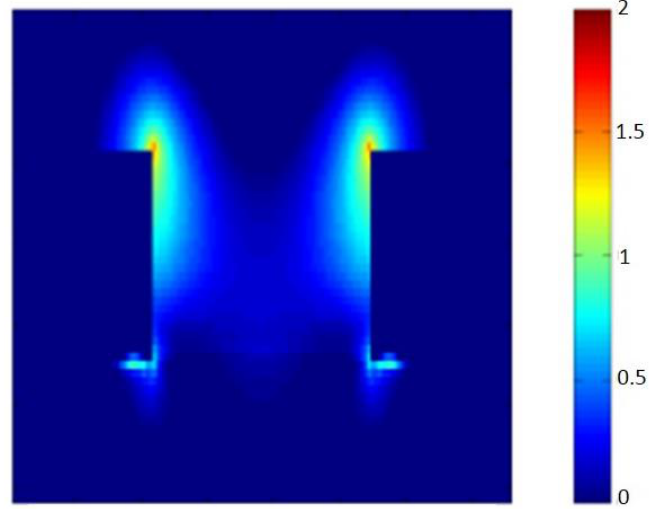
Figure 1. Electric field in the gap between two gold cylindrical nanoparticles for an incident plane wave of wavelength 650 nm. The nanoparticles are in a two-dimensional hexagonal array and have a diameter of 170 nm, height 50 nm, and center-to-center separation of 300 nm. The electric field magnitude is normalized to the magnitude of the incident field. Note the scale is logarithmic from 0 (dark blue) to 2 (dark red). Table 1. Metal enhanced fluorescence in the near infra-red using gold (Au) and silver (Ag) nanoparticles. The excitation and emission rate enhancements are found from lifetime measurements and are not available in every